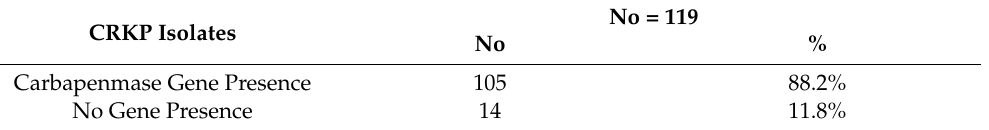
Table 4. Frequency of carbapenemase-encoding genes presence among CRKP